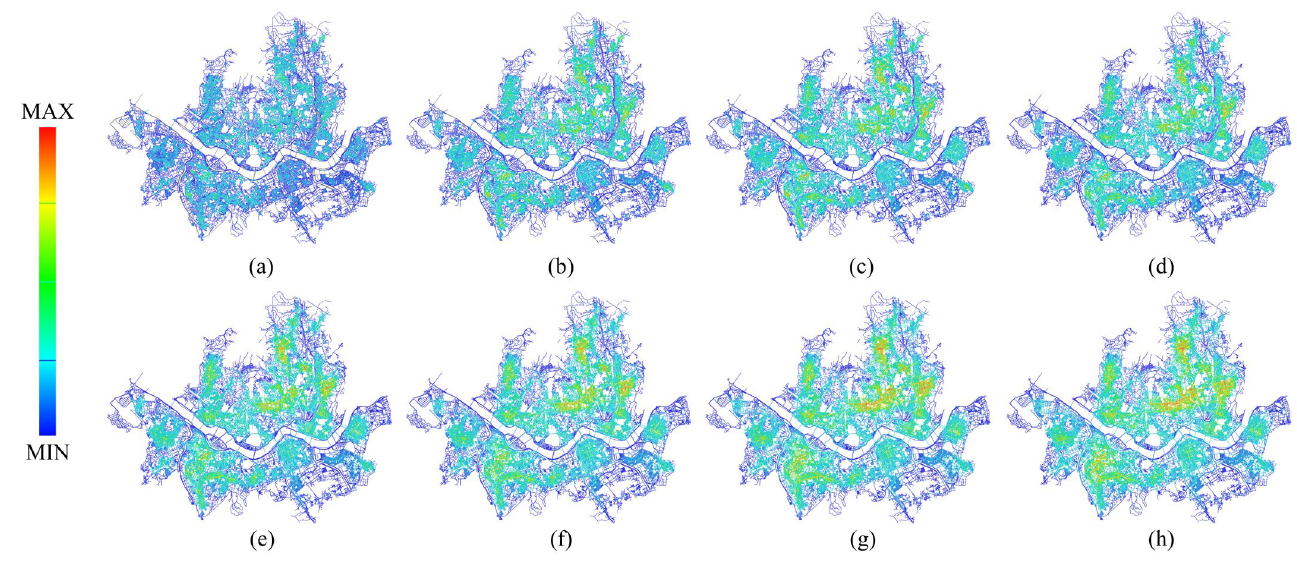
Figure 7. Urban accessibility by angular distance weighting range in Seoul: ( a ) T1024_R250; ( b )